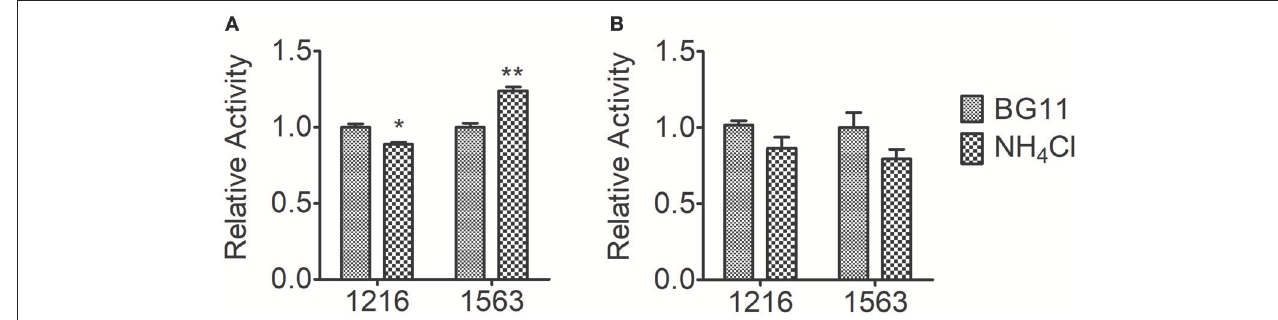
FIGURE 5 | Relative enzyme activity of GS and GOGAT in Chlorella strain FACHB-1216 and FACHB-1563 after incubation for 5h in BG11 and 1g L − 1 NH 4 Cl. (A,B) Represent the enzymes GS and GOGAT, respectively. The control (BG11) values were set to 1 to facilitate comparison. The significance of the differences between the control (BG11) and other values was tested using a one-way ANOVA. * P < 0.05; ** P < 0.01.